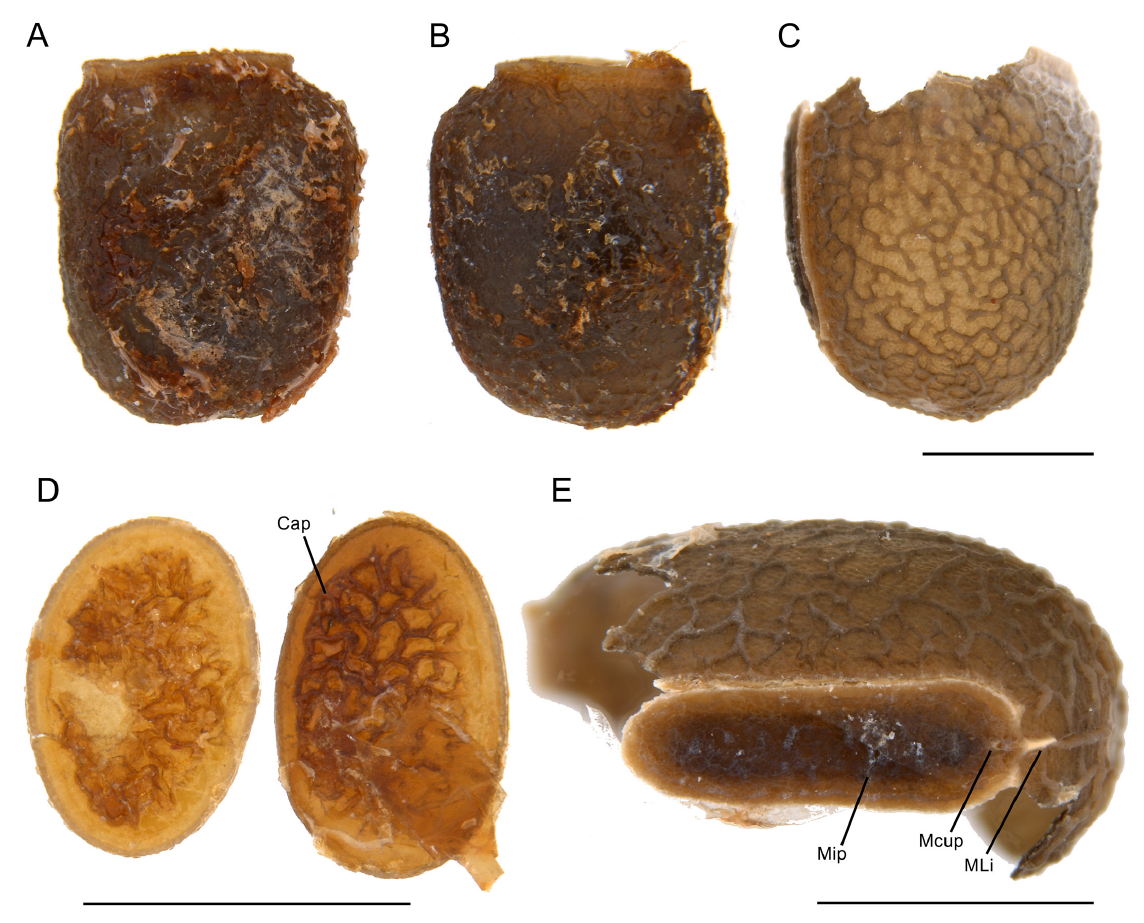
Fig. 18. Arumatia anyami Ghirotto, Crispino & Neves gen. et sp. nov., egg morphology. A–B . Lateral view. C . Posterolateral view of broken egg. D . Two detached operculi in anterior view. E . Dorsal view of broken egg. Abbreviations: Cap = capitulum; Mcup = micropylar cup; Mip = micropylar plate; MLi = median line. Scale bars: 1